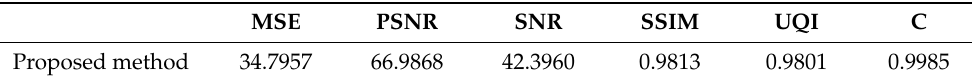
Table 3. Evaluation of the proposed method on the clinical